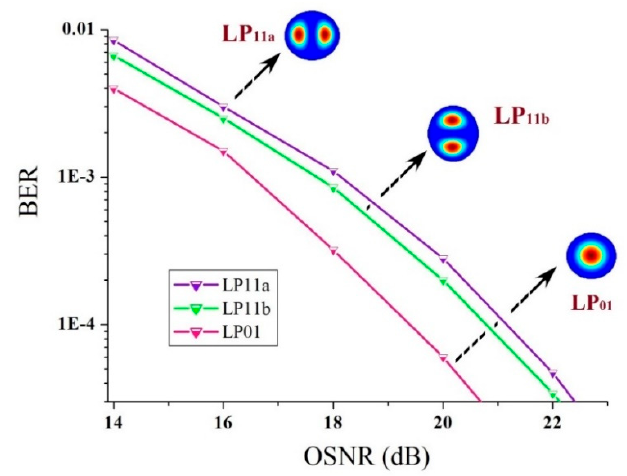
Figure 22. The BER vs. OSNR for three different modes for a PDM-16QAM signal using the STBC-RLS scheme [27].